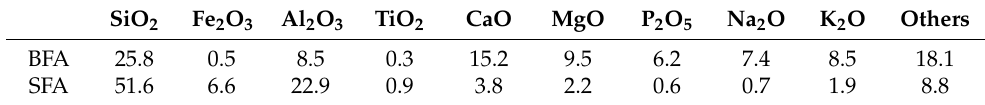
Table 1. Chemical composition of fly ashes